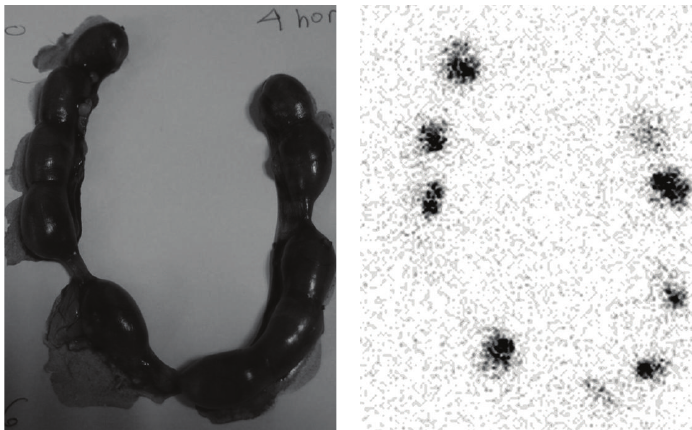
Figure 5: Gammagraphic image of the uterus ex vivo . Different fetal deposits of 111In-oxine are clearly visualized after transplantation with labeled hepatocytes.